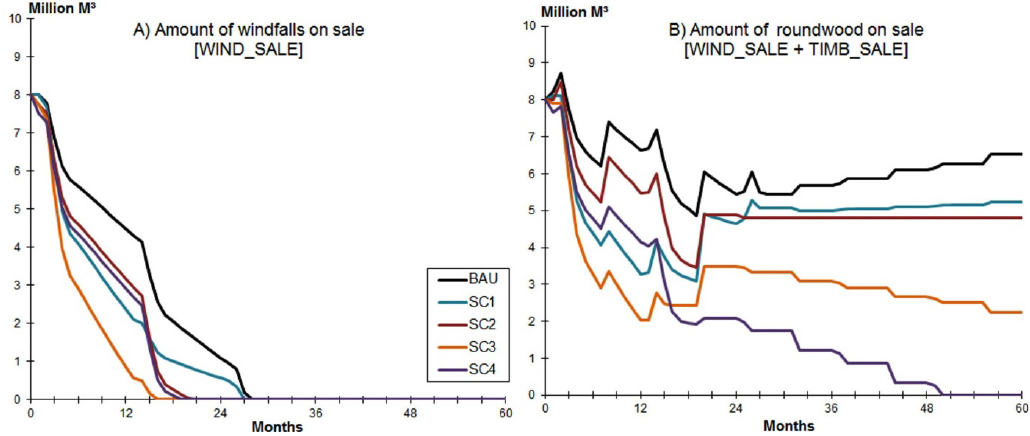
Figure 7. Levels of stocks (million m 3 ) for business-as-usual (BAU) and crisis scenarios (SC1 to